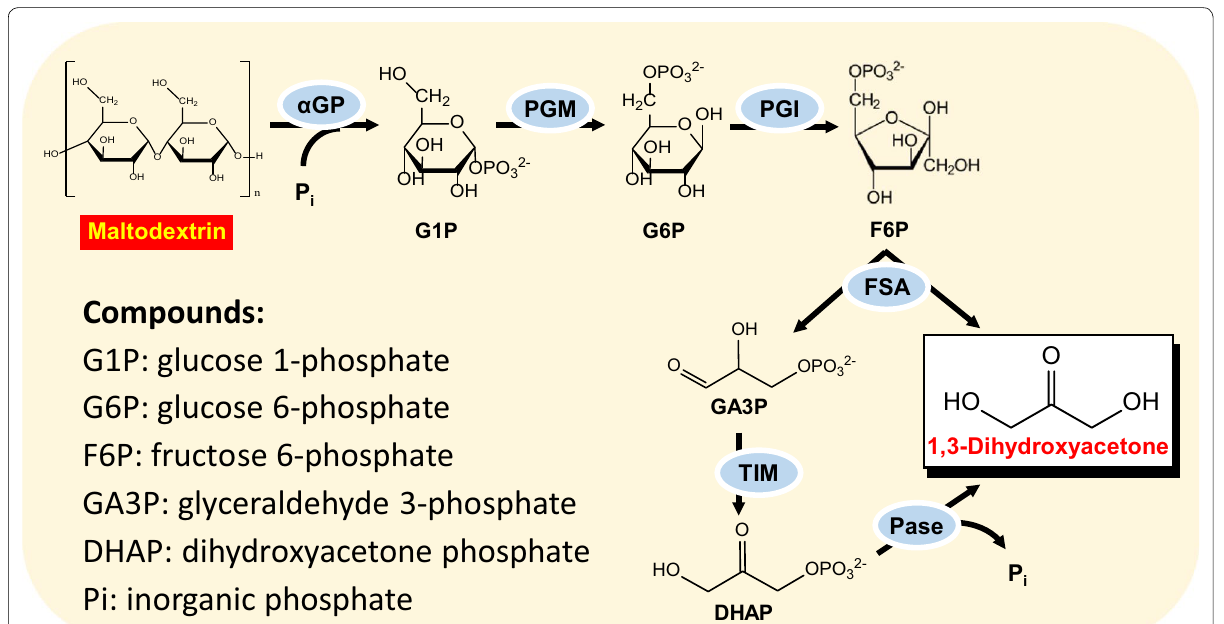
Fig. 6 Scheme of pathway for the conversion of maltodextrin to 1,3-dihydroxyacetone (DHA) by in vitro synthetic enzymatic biosystem. The enzymes are alpha-glucan phosphorylase (αGP), phosphoglucomutase (PGM), phosphoglucose isomerase (PGI), fructose 6-phosphate aldolase (FSA), triosephosphate isomerase (TIM), and phosphatase